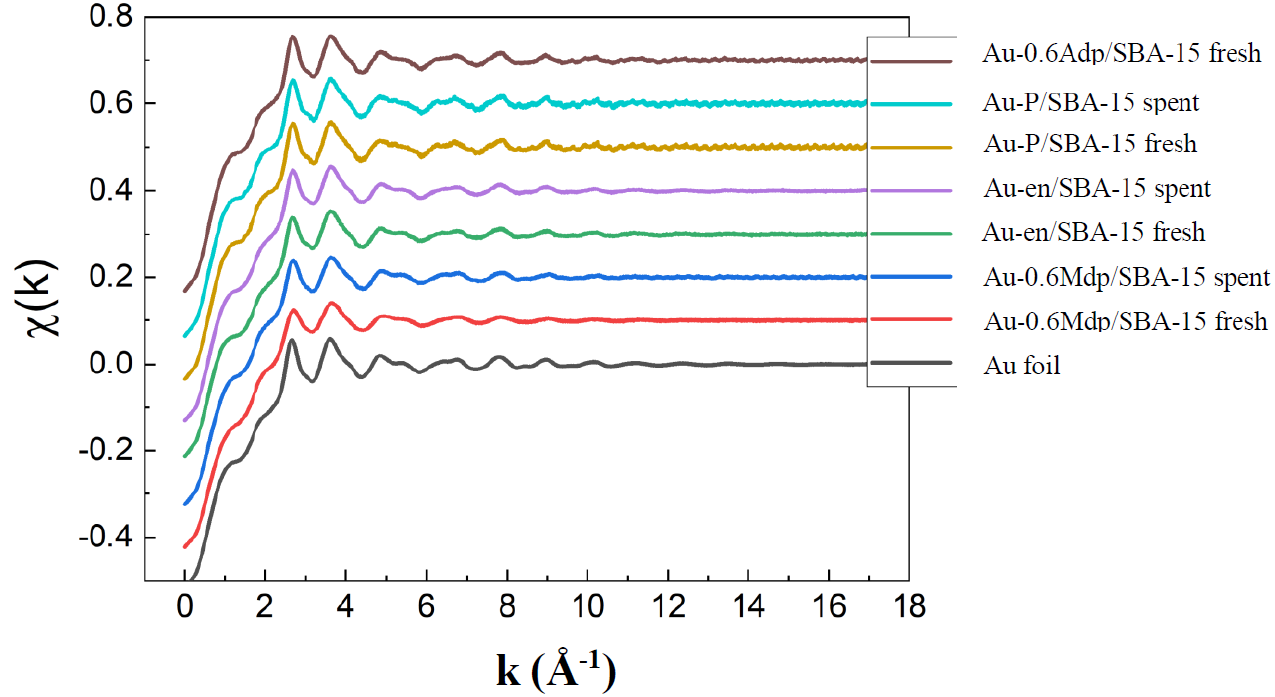
Figure 4. EXAFS spectra of all Au/SBA-15 samples.